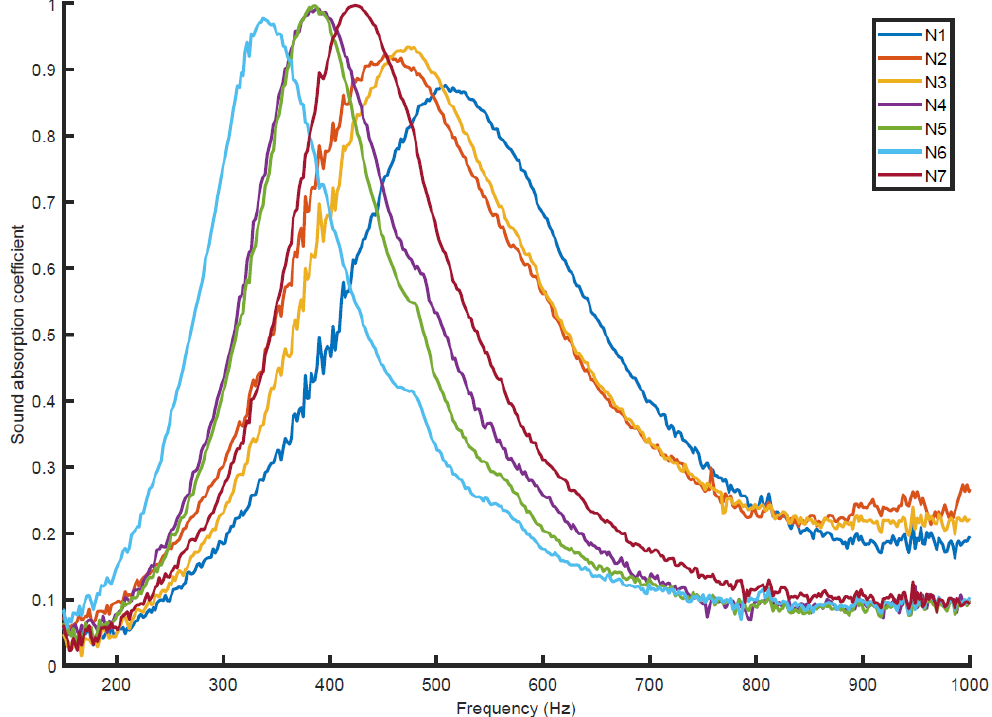
ffi cient for ceramic Figure 5. Sound adsorption coefficient for ceramic resonators. Figure 5. Sound adsorption coe